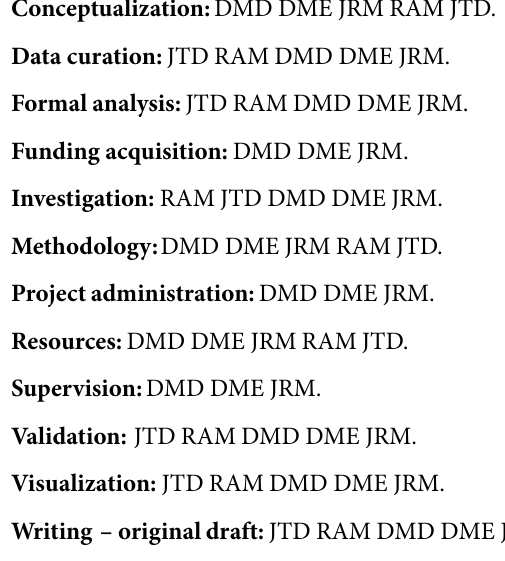
S2 Table. Total abundance of the 14 most common butterfly speciesfor each site by year. Total abundance is the sum of all butterflies counted from six transects within each site in each